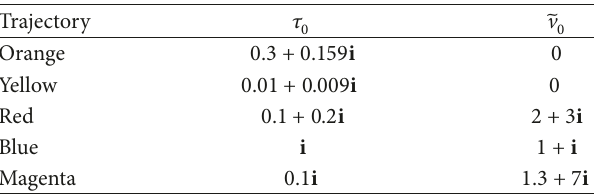
Table 1: Initial conditions for five trajectories on the Poincar´e half